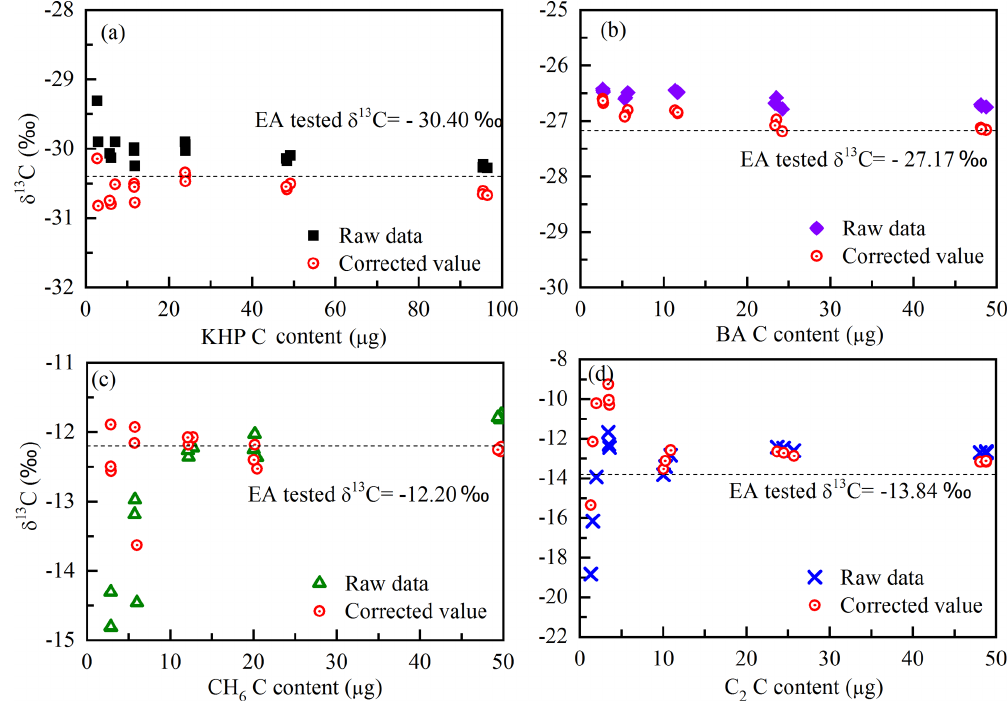
Figure 3. Isotope results before and after the two-step correction of the four standards ( a KHP, b BA, c CH 6 , d C 2 ). Red circles with a spot represent the two-step corrected isotopic ratios; the other symbols represent the raw data from the GasBench II; the dotted line represents the blank-corrected δ 13 C values tested by EA.